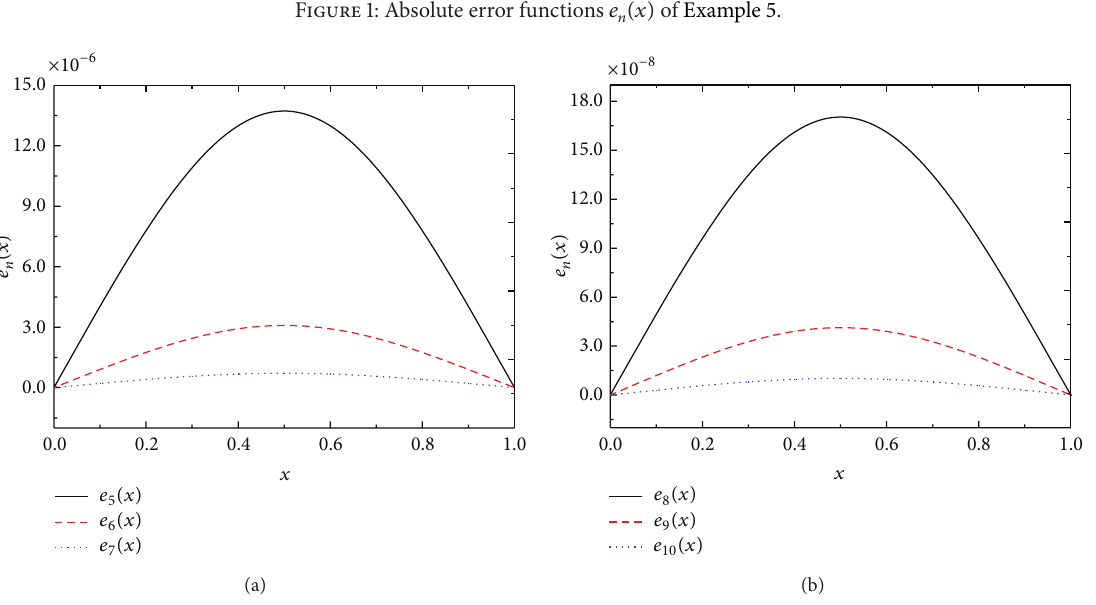
Figure 2: Absolute error functions 𝑒 𝑛 (𝑥) of Example